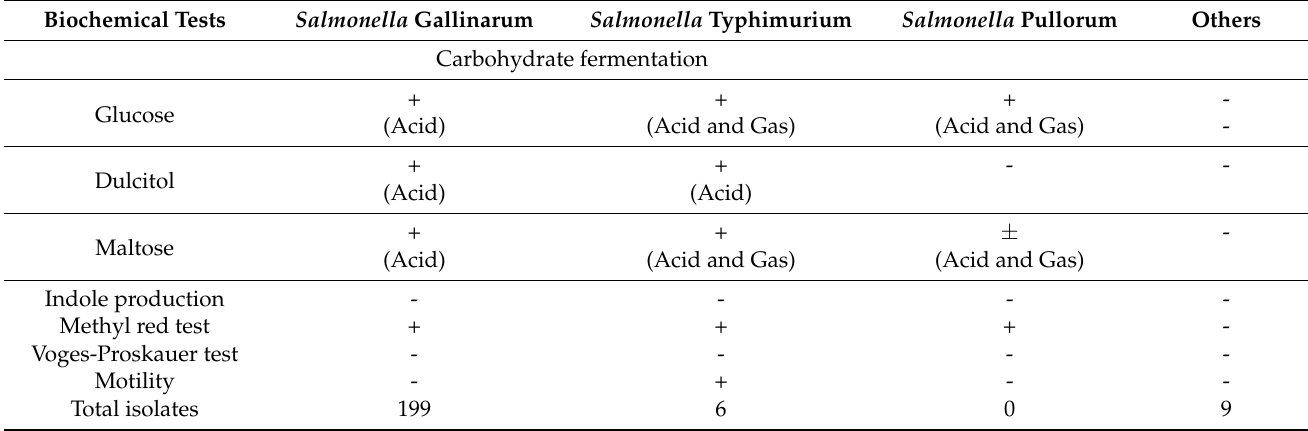
Table 3. Results of different biochemical test among culture positive isolates of Salmonella spp. ( n = 214). Biochemical